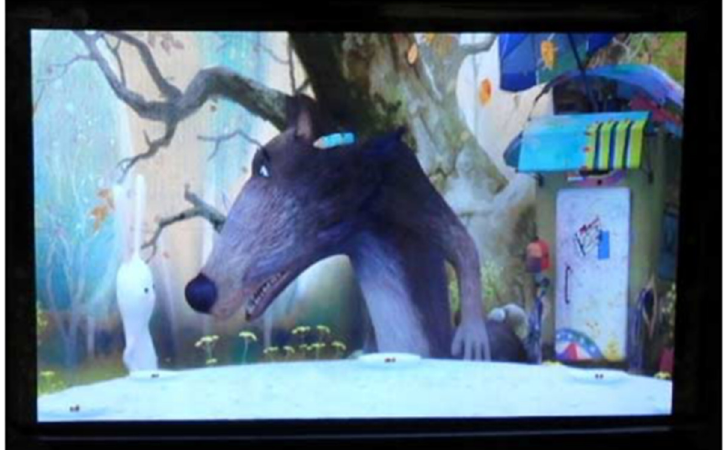
Figure 4. 15-inch blue-phase liquid-crystal display [63]. Invited Paper: The World’s First Blue Phase Liquid Crystal Display from Lee, SID Symposium Digest of Technical Papers; published by John Wiley and Sons.